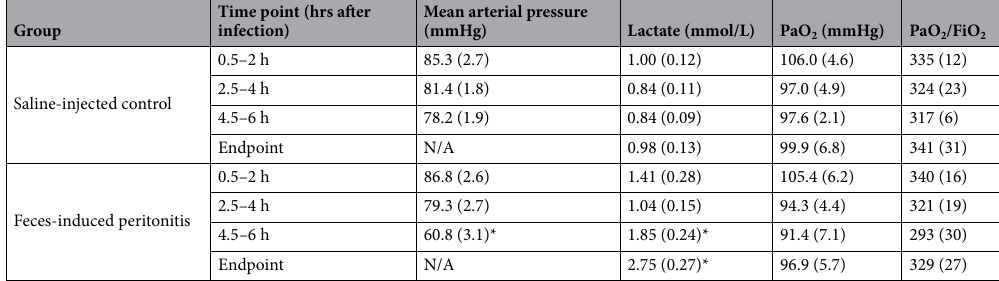
Table 1. Mean arterial pressure, lactate, PaO 2 and PaO 2 /FiO 2 ratios. Data are reported as mean (SEM) and assessed using two-way ANOVA with Bonferroni correction. * P < 0.05 compared with control, n = 10